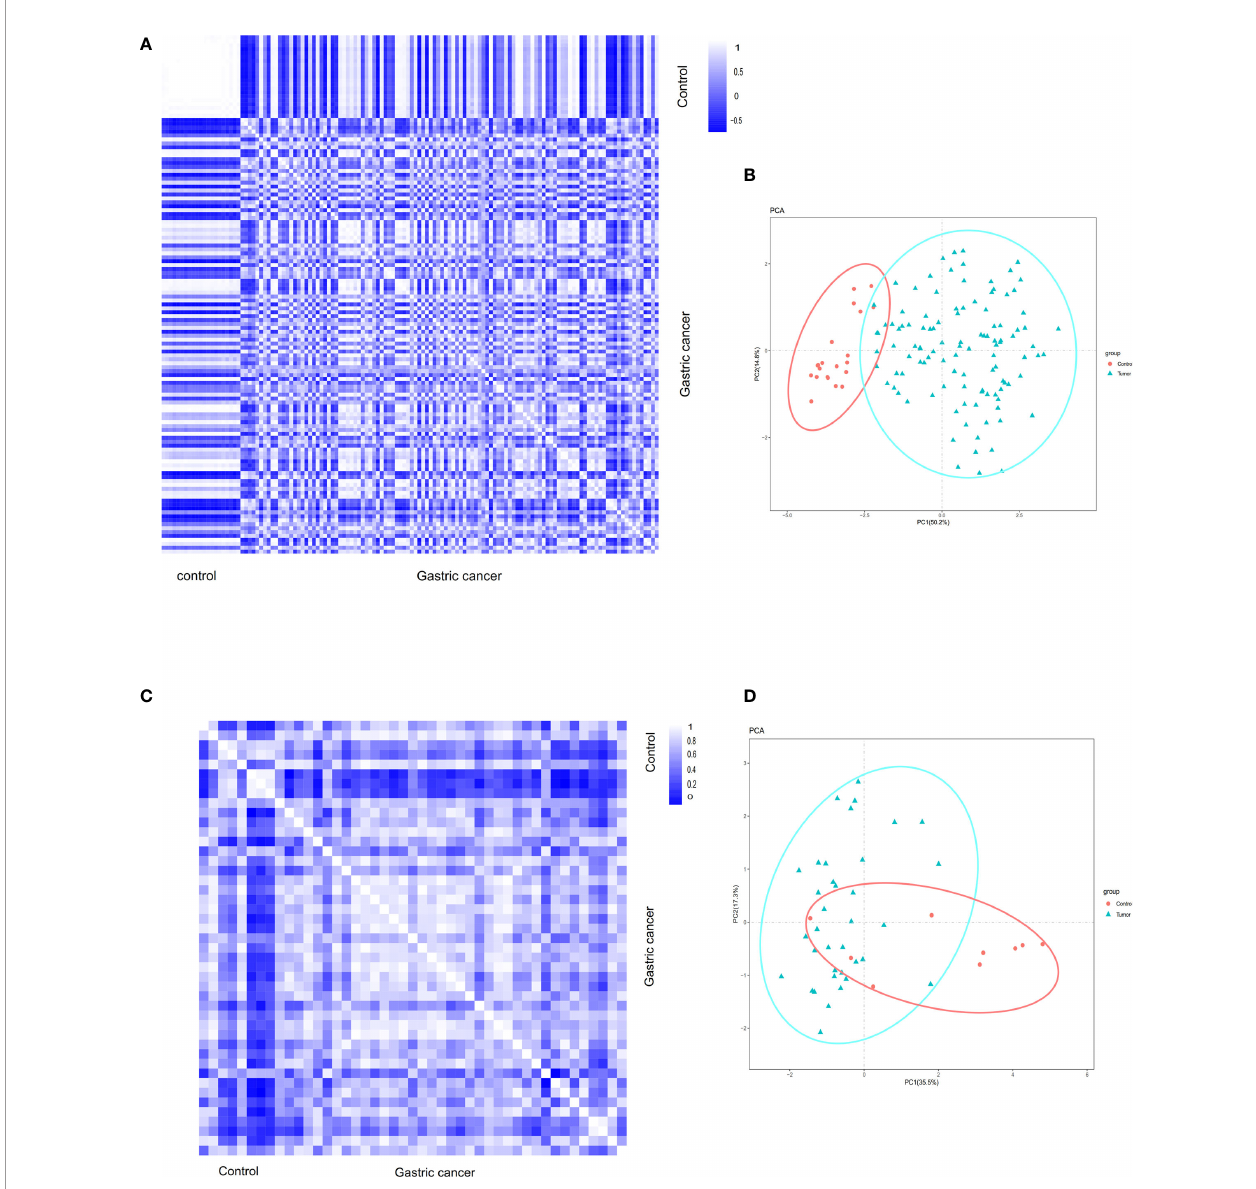
FIGURE 1 | (A) Pearson ’ s correlation analysis of samples from the GSE54129 dataset. The color re fl ects the intensity of the correlation. When 0<correlation<1, there exists a positive correlation. When -1<correlation<0, there exists a negative correlation. The larger the absolute value of a number the stronger the correlation. (B) PCA of samples from the GSE54129 dataset. In the fi gure, principal component 1 (PC1) and principal component 2 (PC2) are used as the X-axis and Y-axis, respectively, to draw the scatter diagram, where each point represents a sample. In such a PCA diagram, the farther the two samples are from each other, the greater the difference is between the two samples in gene expression patterns. (C) Pearson ’ s correlation analysis of samples from the GSE112369 dataset. The color re fl ects the intensity of the correlation. (D) PCA of samples from the GSE112369